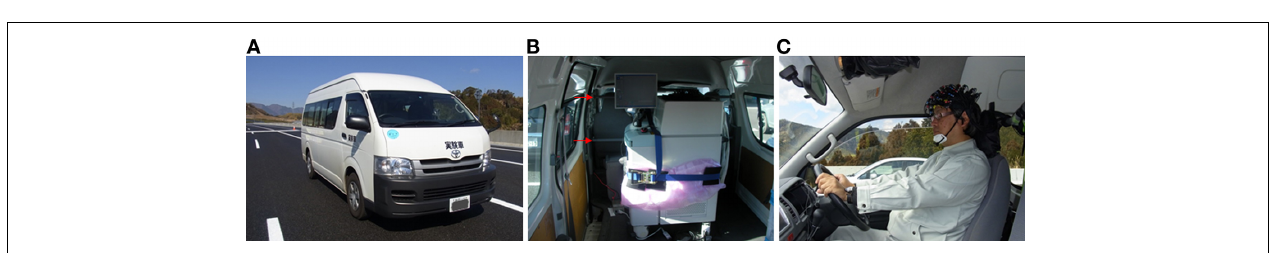
of the course. (B) The U-turn task. A tarpaulin was laid down on the road and the subjects were instructed drive on the tarpaulin during the U-turn.